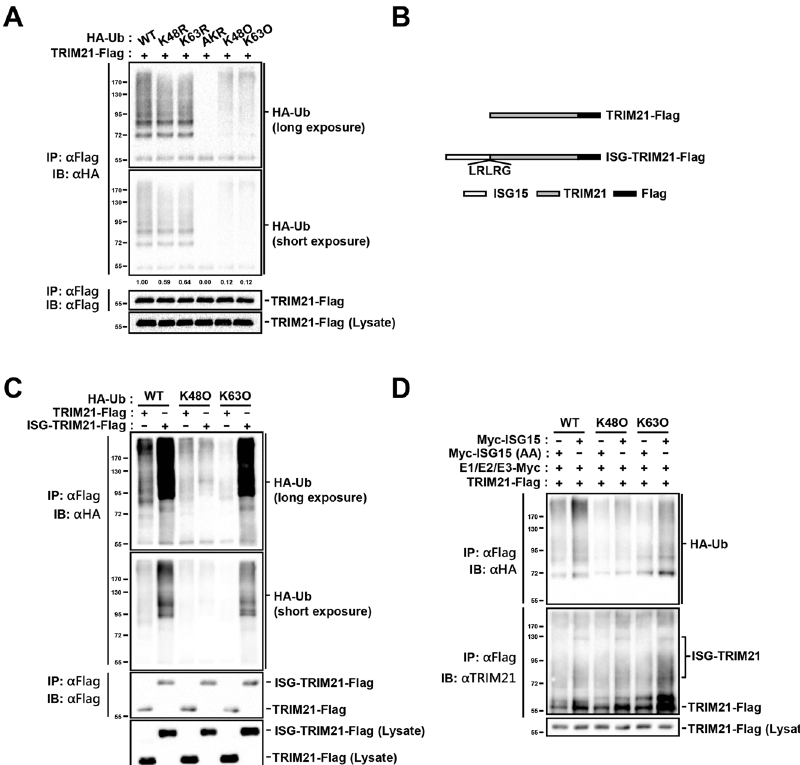
Fig. 4 ISGylation increases TRIM21 K63-linked autoubiquitination. A TRIM21-Flag was co-expressed with HA-ubiquitin (WT) or HA-ubiquitin mutants (K48R, K63R, AKR, K48O, or K63O) in HEK293 cells. Cell lysates were lysed in denaturing RIPA buffer, followed by immunoprecipitation with mouse Flag antibodies. The immunoprecipitates and cell lysates were detected with rabbit Flag antibodies and HA antibodies. B Schematic representation of TRIM21-Flag and ISG-TRIM21-Flag. ISG15-LRLRG was added to the N-terminal of TRIM21 to mimic the ISGylation of TRIM21. C TRIM21-Flag or ISG-TRIM21-Flag was co-transfected with HA-unbiquitin (WT) or HA-ubiquitin mutants (K48O or K63O) into HEK293T cells. Cell lysates were pre-processed in denaturing condition as did in A and immunoprecipitated with mouse Flag antibodies, followed by immunoblotting with rabbit Flag and HA antibodies. Cells lysates were detected by rabbit Flag antibodies. D TRIM21-Flag along with HA-unbiquitin (WT) or HA-ubiquitin mutants (K48O or K63O) were co-expressed with or without ISG15-conjugating system (UBE1L-Myc (E1), UBCH8-Myc (E2), HERC5-Myc (E3), and HA-ISG15) in HEK293 cells. Cell lysates were also denatured as in A , and pulled down with mouse Flag antibodies. Cell lysates and immunoprecipitates were detected with rabbit Flag and HA antibodies. Data shown are representative of three independent